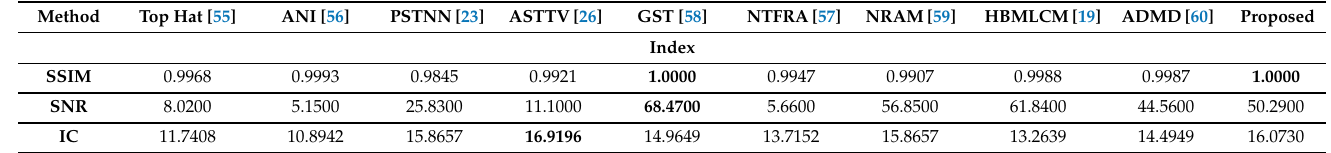
Table 9. Calculation of indicators in scenario E of each model.